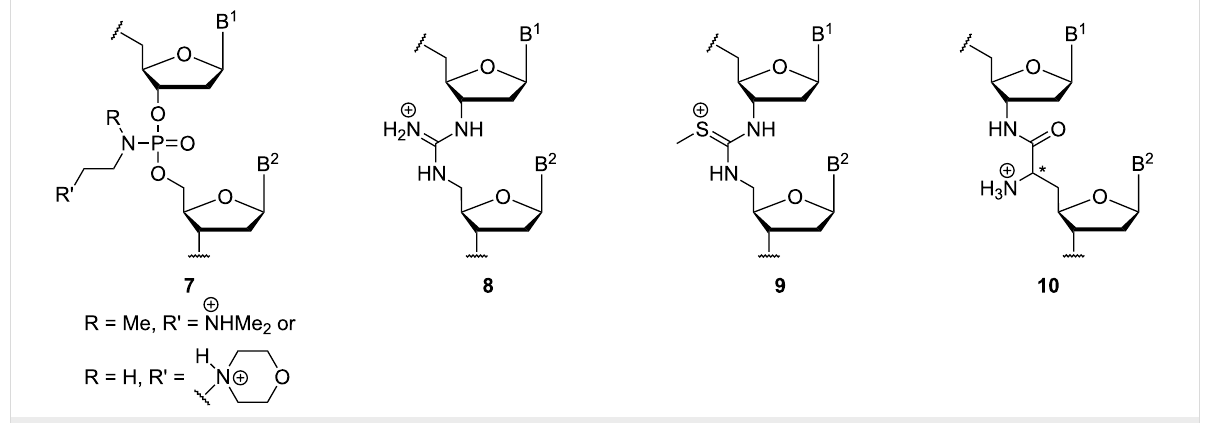
Figure 3: Oligonucleotide analogues with artificial cationic backbone linkages discussed in this review: aminoalkylated phosphoramidates 7 (and related systems, not shown), guanidinium-linked 'DNG' 8 , S -methylthiourea-linked oligomers 9 , and nucleosyl amino acid (NAA)-modified oligonucleo- tides 10 (B 1 , B 2 =